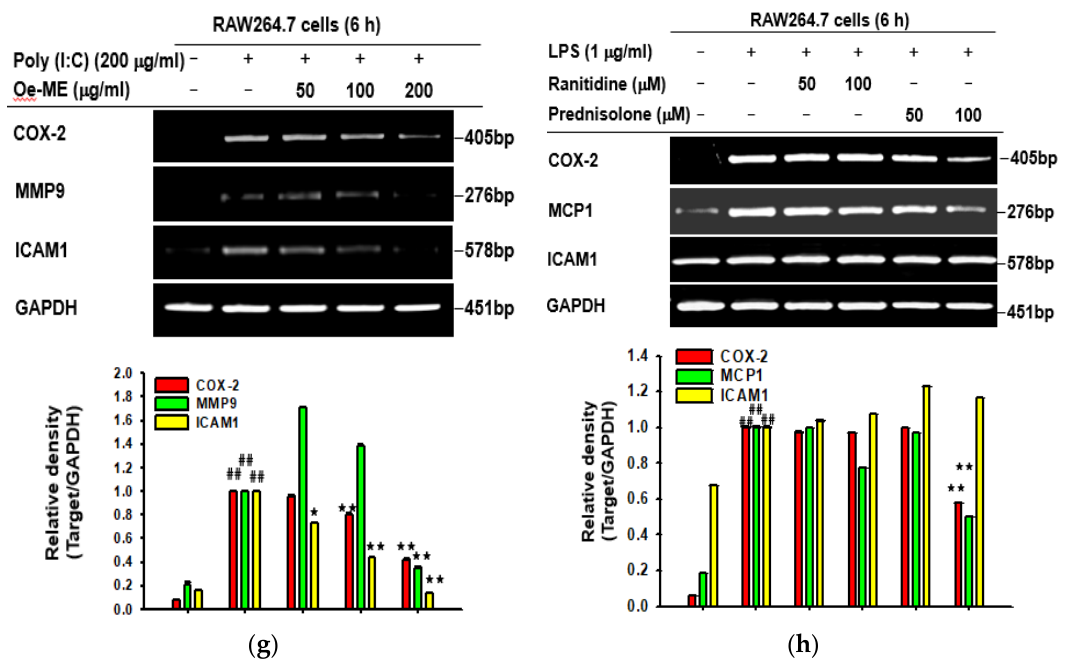
Figure 1. Cell viability and the effect of Oe-ME on mRNA expression of inflammation-related genes. ( a ) RAW264.7 and HEK293T cells were treated with indicated doses of Oe-ME (50, 100, and 200 μ g/mL) and then incubated for 24 h. Cell viability was measured using an MTT assay. ( b , c , d ) After pretreatment with Oe-ME for 30 min, RAW264.7 cells were exposed to LPS and real-time PCR were employed to assess the production of TNF- α , COX-2, and IL-6. ( e , f , g , h ) RAW264.7 cells were incubated with LPS, poly (I:C), or pam3CSK4 in the absence or presence of various concentrations of Oe-ME. The mRNA expression levels of ICAM-1, IL-2, COX-2, MMP-9, and MCP1 were measured by RT-PCR. Prednisolone and ranitidine were used as positive and negative control drugs, respectively. Band intensity was measured and quantified using ImageJ. ## p < 0.01 compared with the normal group, and * p < 0.05 and ** p < 0.01 compared with the LPS, pam3CSK4, or poly (I:C) alone groups treated with the corresponding concentration of the vehicle (DMSO).